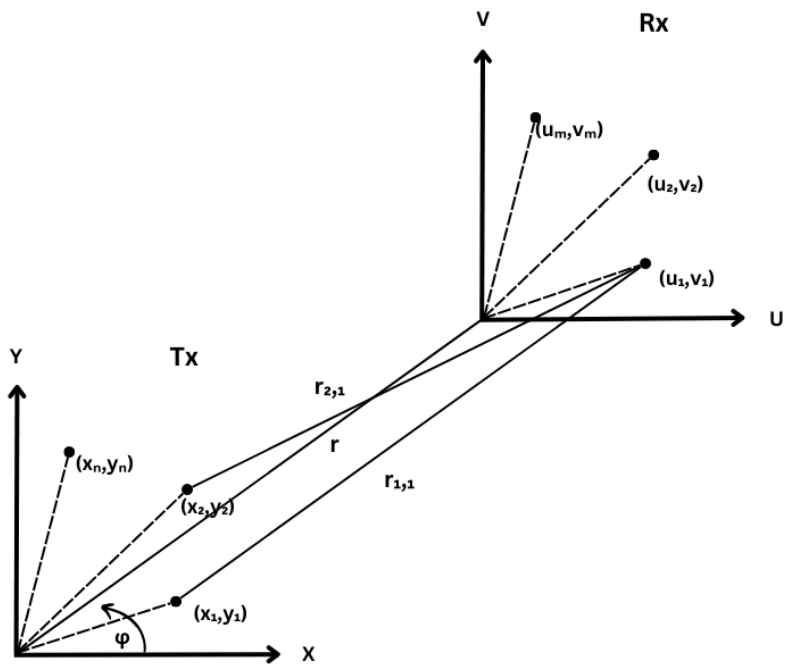
Figure 3. Schematic diagram of the MIMO antenna on XY and UV coordinate planes.